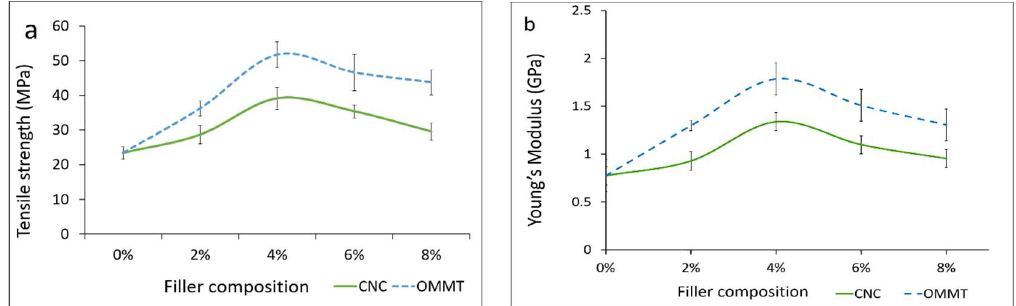
Figure 1. Effects of different types of reinforcement and variations in filler loading on ( a ) tensile strength; and ( b ) Young’s modulus.